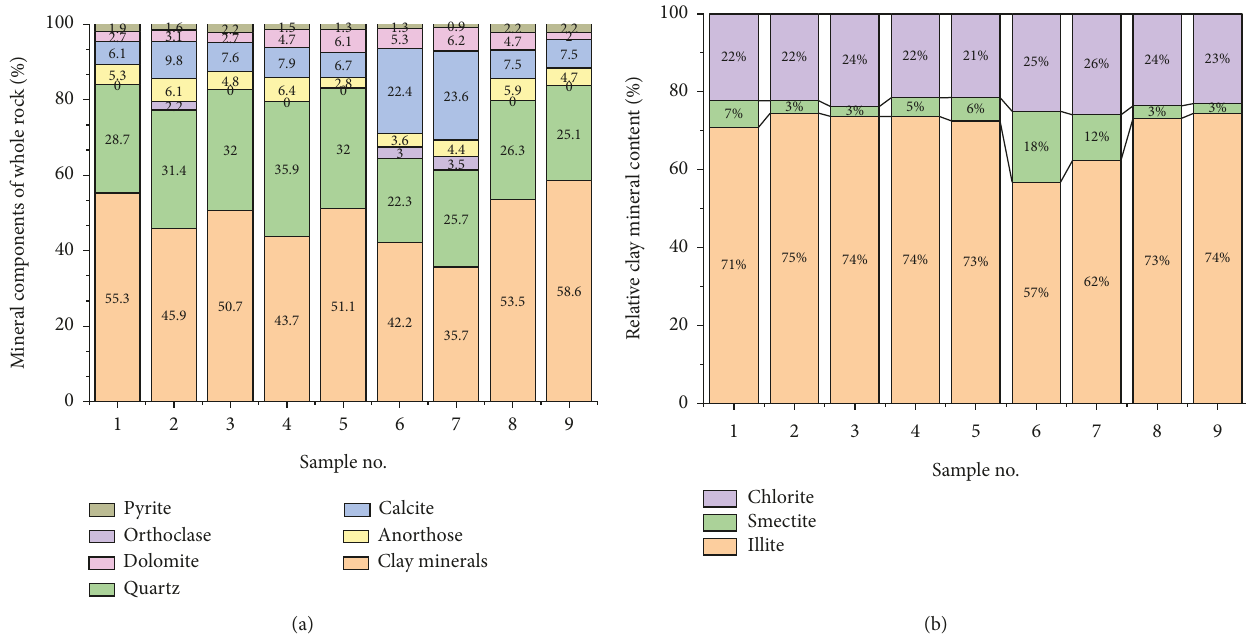
Figure 2: Composition analysis of minerals in LMX shale ((a) mineral components of whole rock, (b) relative clay mineral content).